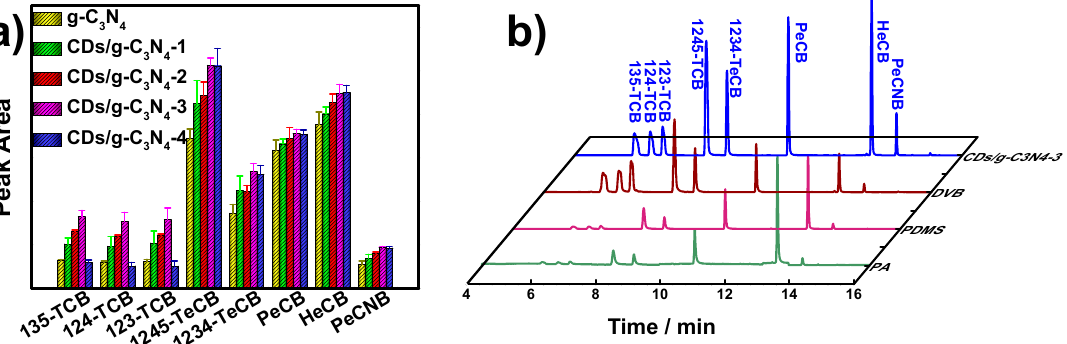
Figure 4. Extraction efficiencies of pristine g-C 3 N 4 and CDs/g-C 3 N 4 composites with different doping amounts of CDs ( a ); GC-MS chromatograms of CBs by CDs/g-C 3 N 4 -3 and commercial SPME coatings ( b ). Error bars represent the standard deviation of the mean ( n = 3).